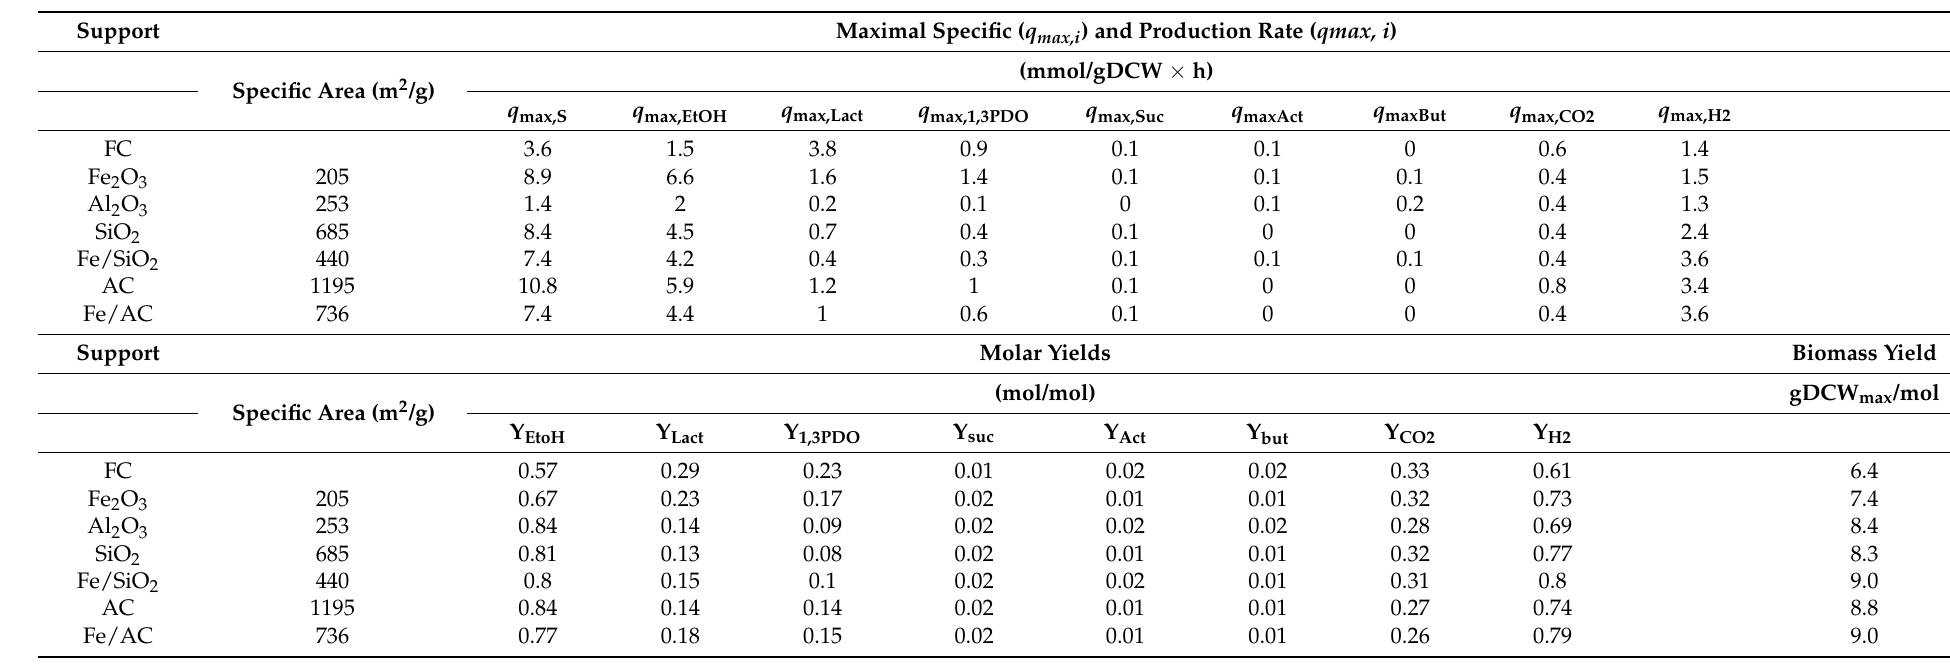
Table 3. Maximum specific productivity and